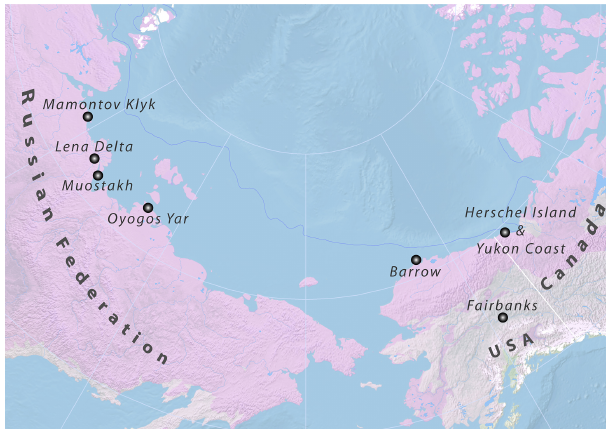
Figure 1. Study area and study sites (dots) for massive ground- ice sampling in the Arctic lowlands of Siberia and North Amer- ica. All study sites are located within the zone of continuous per- mafrost (dark purple), except for the Fairbanks area, which is the zone of discontinuous permafrost (light purple). Blue line in the Arctic Ocean marks the northerly extent of submarine permafrost according to Brown et al.